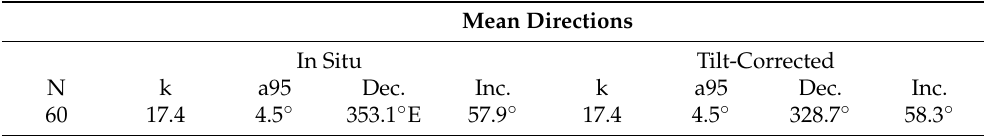
and TS10 from the Siena–Radicofani Basin in